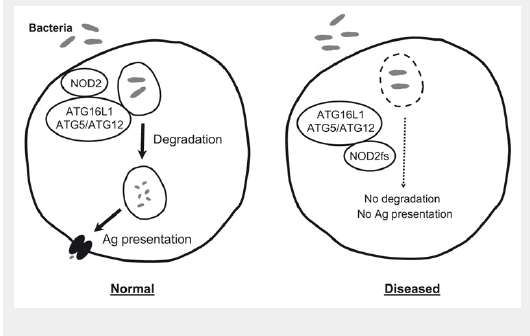
NOD2/CARD15 initiates the autophagic process. Normal) NOD2/ CARD15 colocalises with the ATG16L1 at a bacterial entry site, leading to recruitment of the ATG5-ATG12 complex for autophagosome formation. After fusion of the autophagosome with the lysosome, bacteria are degraded and some constituents are used for antigen presentation via major histocompatibility complex (MHC) class II, leading to immune system activation and bacterial clearance. Diseased) Mutant NOD2/CARD15 fails to localise at the plasma membrane and retains ATG16L1 in the cytosol. Impaired autophagosome formation leads to ineffective bacterial degradation and diminished antigen